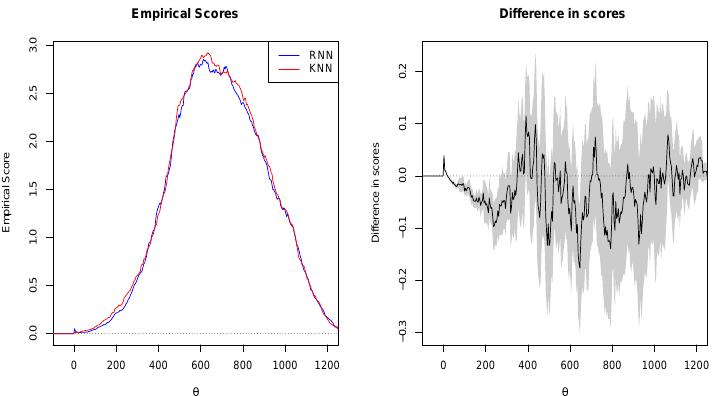
Figure 8. Plots of the RNN and KNN forecasts showing the relationship between their empirical scores ( left panel ) and the differences in empirical scores with 95% confidence intervals ( right panel ).